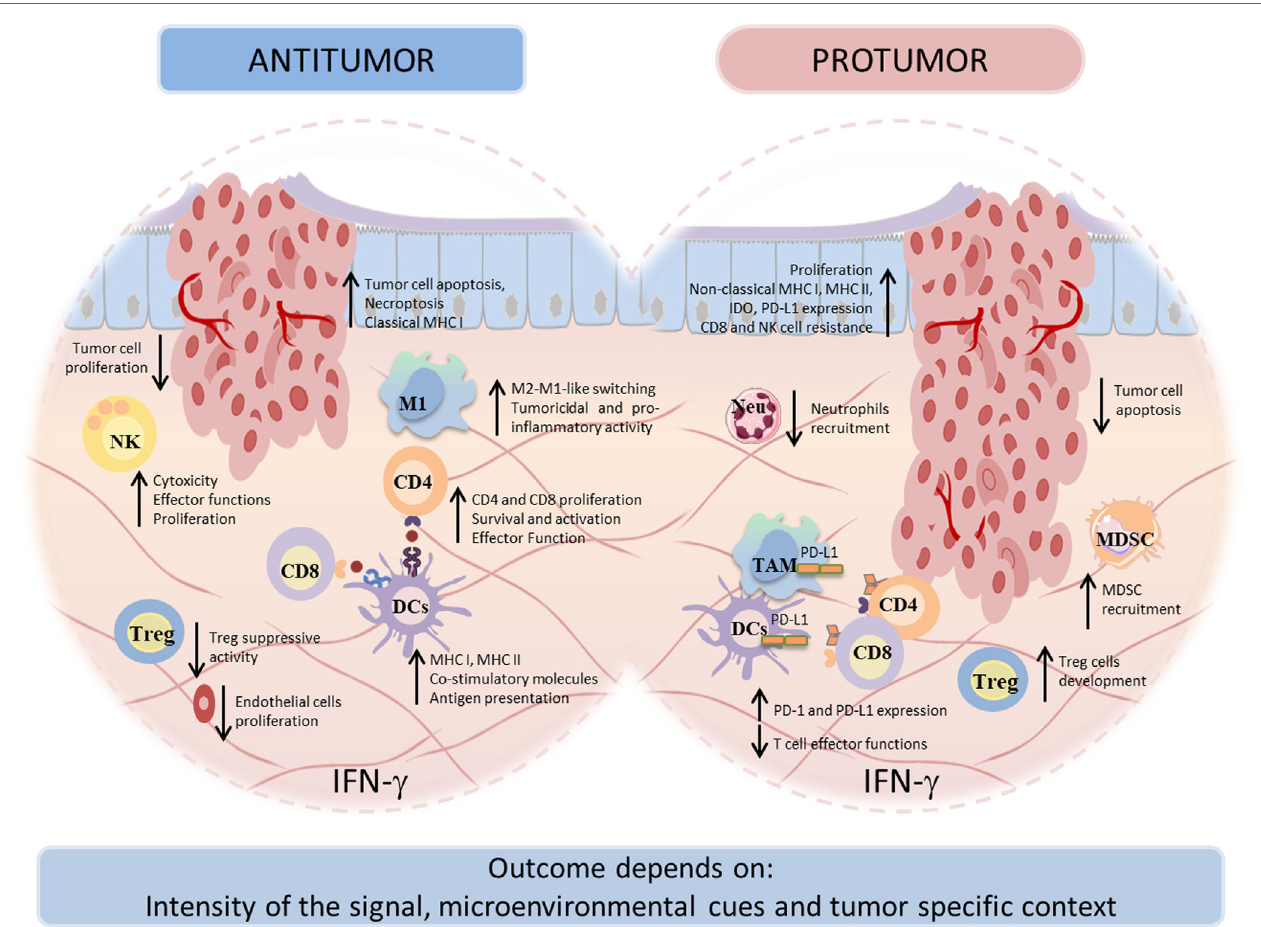
FiGURe 3 | Dual face of interferon-gamma (IFN- γ ) in tumor immunity. IFN- γ can display both antitumor and protumor activities. Under both circumstances, IFN- γ influences tumor cells directly and indirectly, by activation of immune cells. The antitumor effects comprise the development, recruitment, and activation of innate immune cells as well as the activation and maintenance of effector T cells. The antitumor effects of IFN- γ result in direct inhibition of tumor proliferation, recognition, and elimination. In other way, the protumorigenic role of IFN- γ involves proliferative and antiapoptotic signals, as well as escape of the tumor cells from recognition and cytolysis by cytotoxic T lymphocytes (CTLs) and natural killer (NK) cells. The broad range of IFN- γ actions depends on the context of tumor specificity, IFN- γ -signaling intensity, and other microenvironment